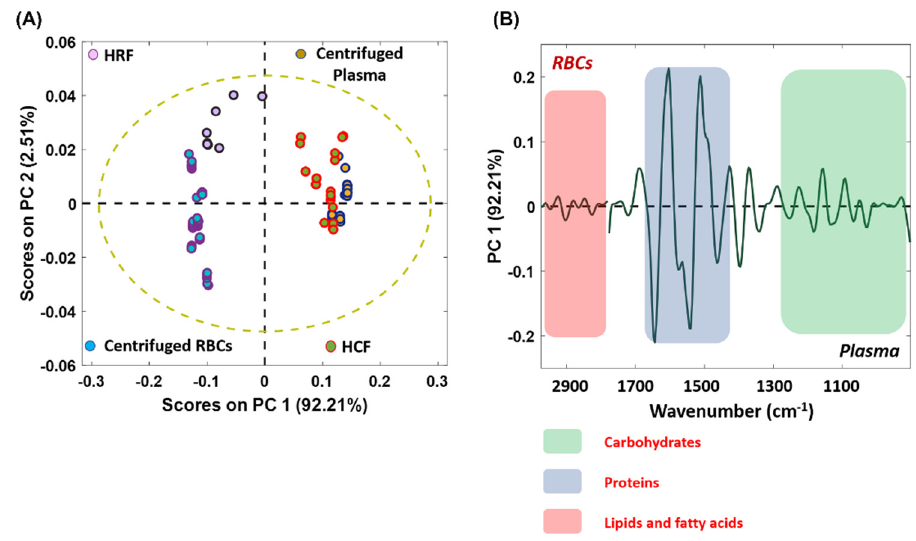
Figure 10. ( A ) 2D PCA score plot on the dataset consisting of HCF, HRF, plasma and RBCs from centrifugation method and, ( B ) the corresponding loading plot.